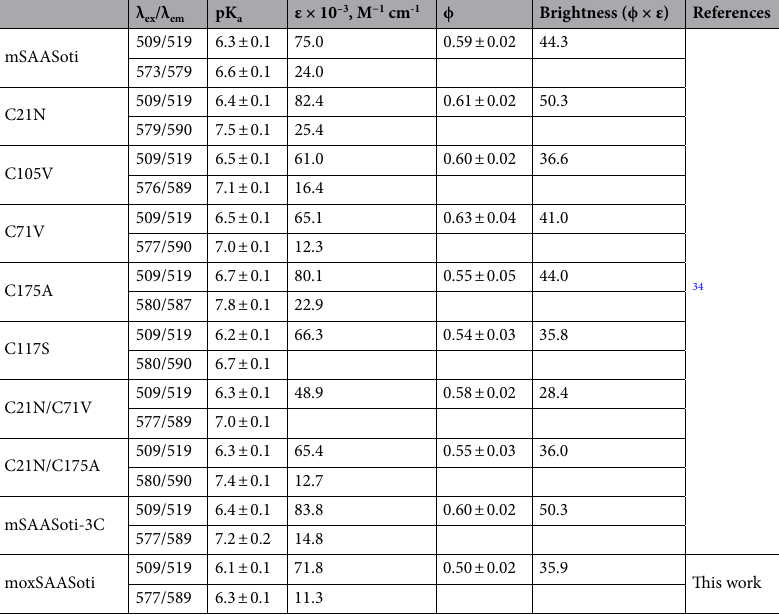
Table 4. Physicochemical properties and fluorescent parameters of different mSAASoti mutant